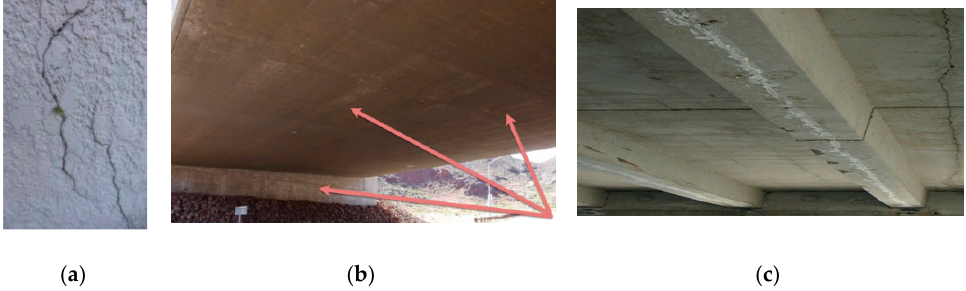
Figure 1. Examples of cracks in concrete: ( a ) typical micro-cracking; ( b ) conventional inspection of bridge cracks; ( c ) cracks along a slab in a mall.